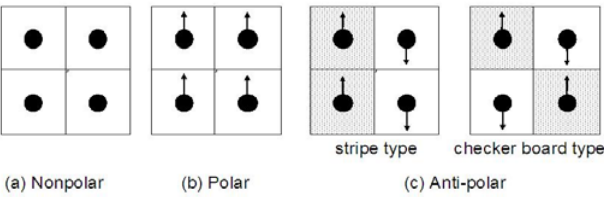
Figure 3. Two antipolar dipole arrangement models ( c ) in contrast to nonpolar ( a ) and polar ( b ) models.